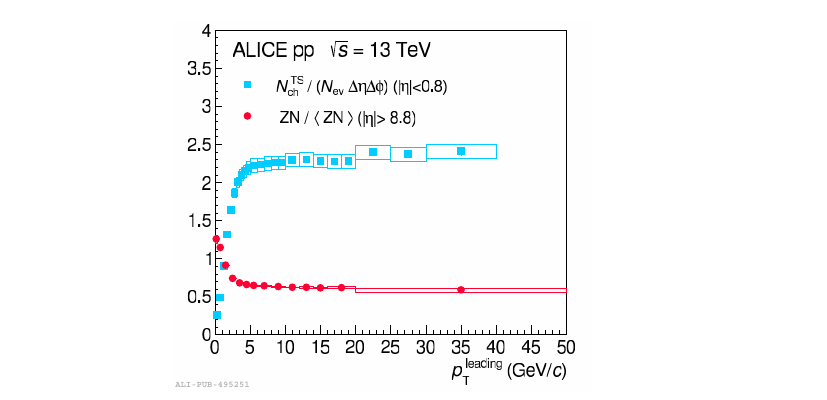
Figure 2: Multiplicity density (azure squares) in the transverse region [8] and self-normalised ZN signal (red circles) as a function of p leading √ s = 13 TeV. Figure 1: Multiplicity density as a function of p trig measured in pp (left) and p–Pb (right) T collisions at √ s NN = 5 . 02 TeV. Results for the toward, transverse, and away regions are displayed. The shaded boxes and the error bars represent the systematic and statistical uncer- tainties, respectively.